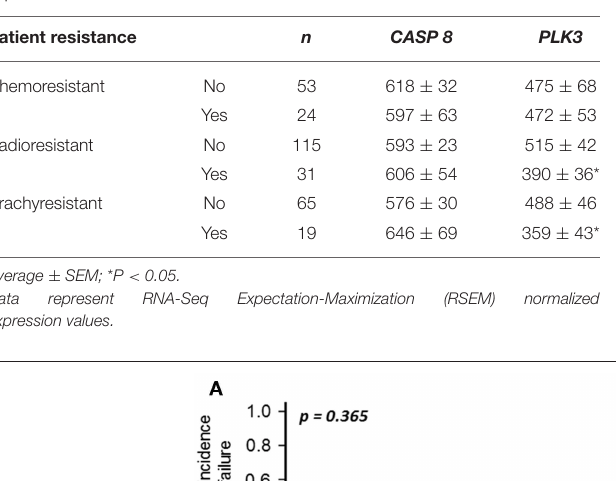
TABLE 4 | Development of resistance according to PLK3 and Caspase 8 gene expression. Patient resistance n CASP 8 PLK3